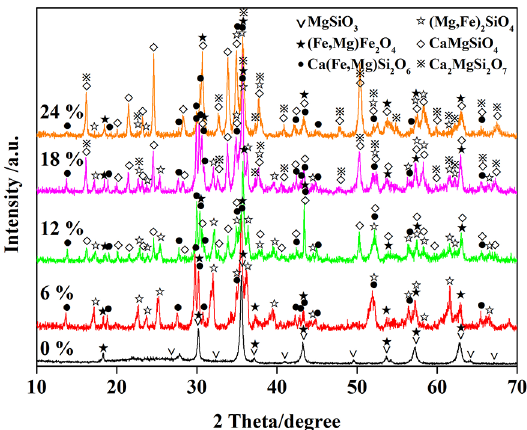
Figure 5. XRD patterns of samples at different w (CaO) when F/S and M/S were fixed as 1.53 and 0.50, respectively. Note : enstatite (MgSiO ), magnetite ((Fe,Mg)Fe O ), augite (Ca(Fe,Mg)Si O ), 3 2 4 2 6 forsterite ((Mg,Fe) SiO ), monticellite (CaMgSiO ), and akermanite 2 4 4 (Ca MgSi O ) are the group member of orthopyroxene, spinel, 2 2 7 clinopyroxene, olivine, olivine, and melilite, respectively.